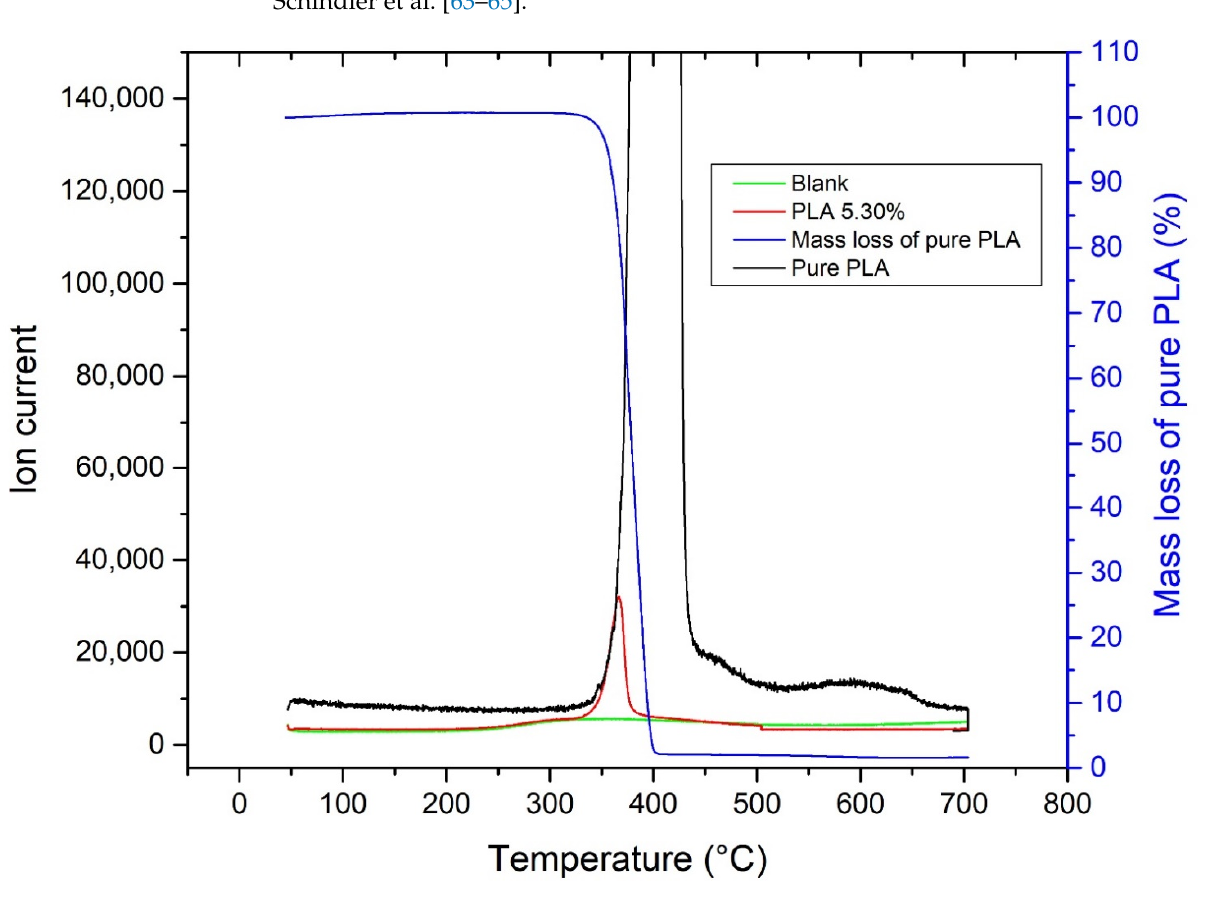
Figure 2. The plot of the peaks at m / z 29 of blank, pure PLA and P185 soil containing 5.30% PLA suitable for PLA detection.